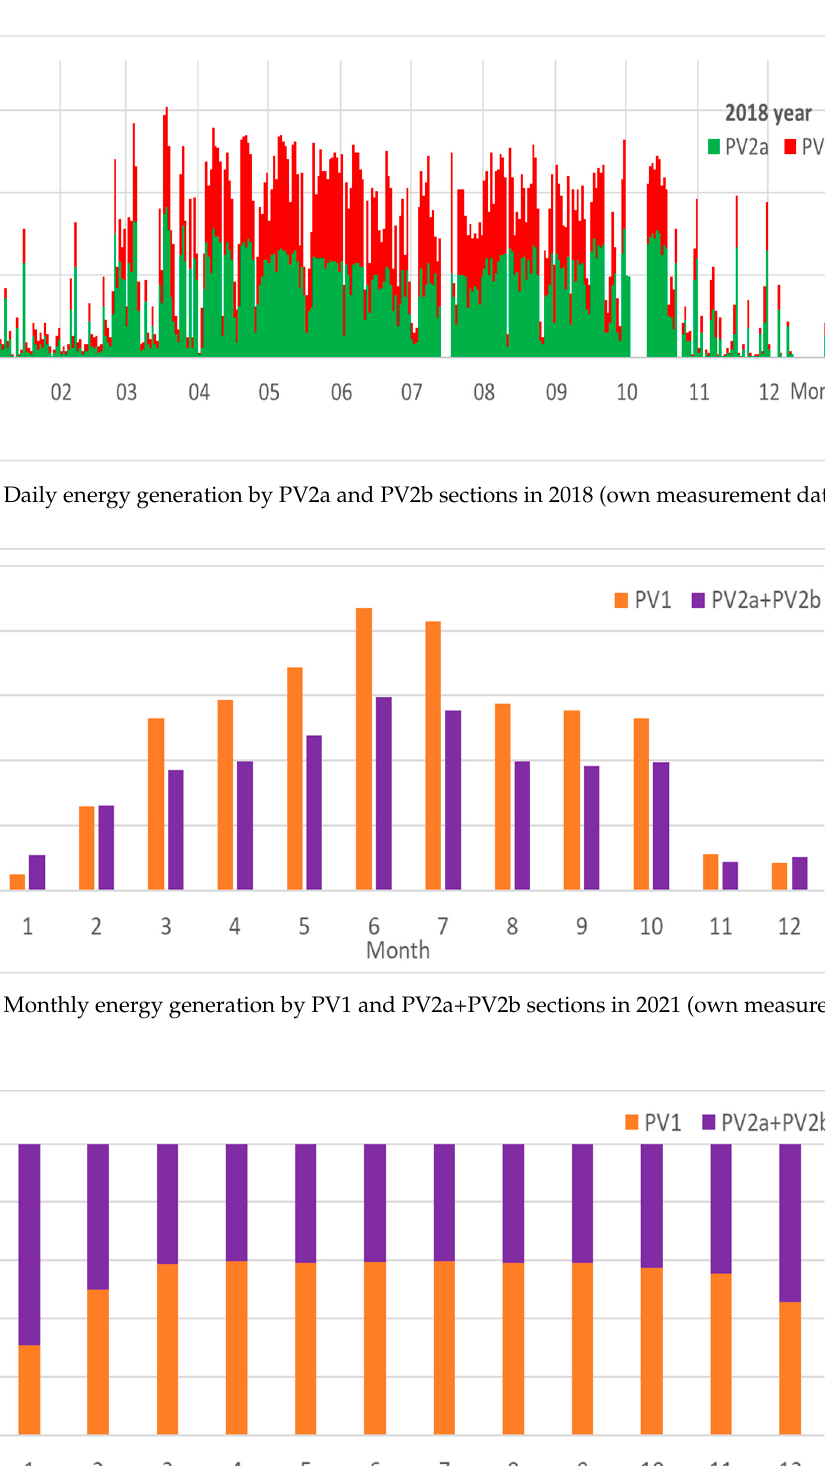
Figure 20. Monthly energy generation by PV1 and W1 sections in 2021 (own measurement data). Figure 21. Share of PV1 and W1 sections in monthly generation of PV1 and W1 sections in 2021 (own measurement data). The split and the discussed location of the PV panels should be taken into account if there are limitations in the location of the installation and the possibility of releasing mo- mentary surplus energy to the power grid. It should be remembered that the reduction in the energy “stored” in the grid is 20% or 30%, depending on the size of the installation, in the net metering system. In such a situation, reducing the generation in section PV2a by